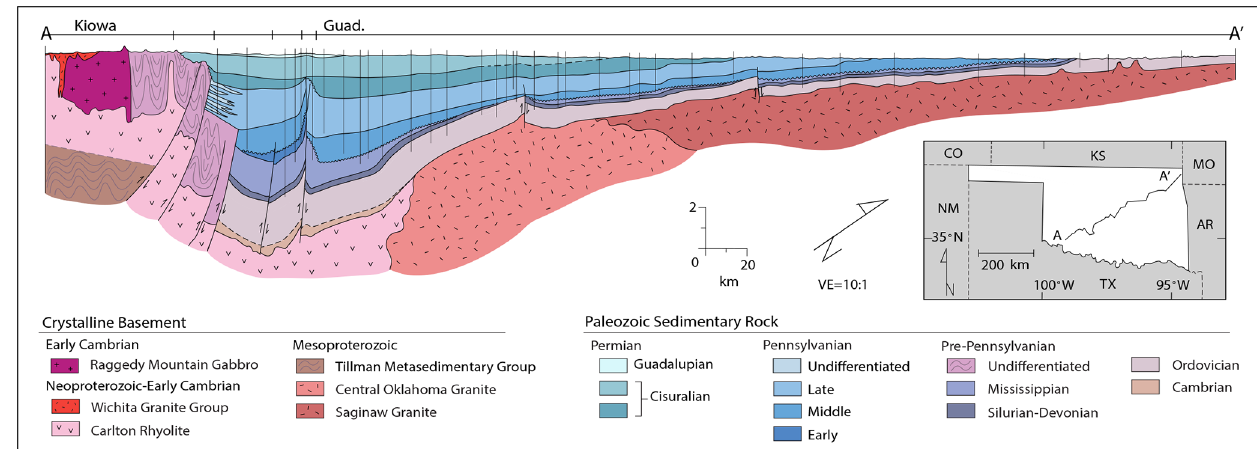
Figure 6. Cross section of the Anadarko Basin, from the basin deep (SW) to the shelf (NE). Thin vertical lines are locations of the boreholes (logs) used for the interpretation. The seismic line (shown as “S” on the inset map) in Fig. 7 depicts (approximately) the boxed region. Cross section modified from Witt et al.